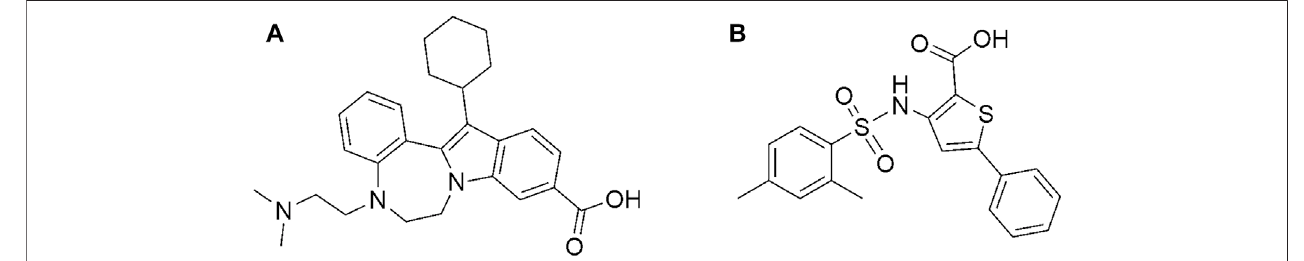
FIGURE 5 | Chemical structure of (A) CHEMBL1204385 and (B)